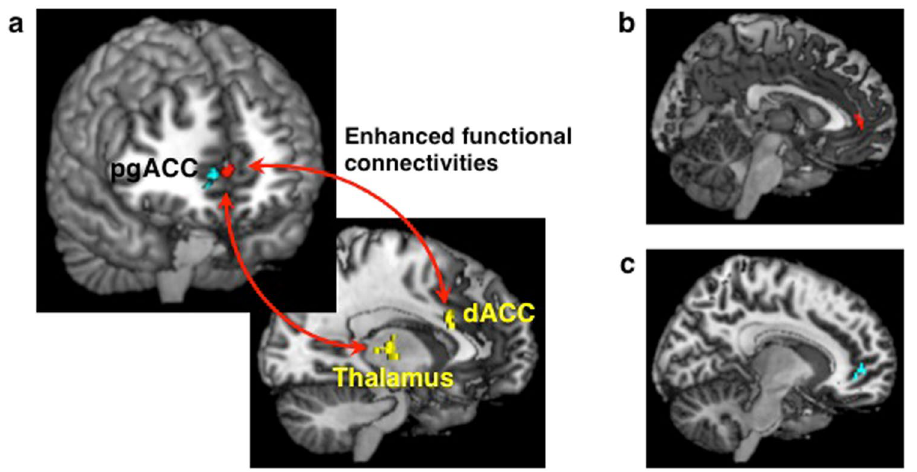
Figure 3. ( a ) Neural basis of negativity bias in facial perception. Activation of the bilateral pgACC (peak Montreal Neurological Institute coordinates: x, y, z = 0, 46, 4; Z = 3.55, red cluster in upper panel) during “sad” versus “happy” choices in response to ambiguous faces was negatively correlated with the point of subjective equality (PSE). The Beck Hopelessness Scale (BHS) score was positively correlated with functional connectivities of the bilateral pgACC with the right dACC and right thalamus (yellow clusters in lower panel). The right pgACC (x, y, z = 8, 46, 2; Z = 4.23, blue cluster in upper panel) exhibited a significant negative correlation with the PSE in the contrast of 100% “sad” versus 100% “happy” faces. Significant clusters in the left putamen and the left orbitofrontal cortex are not displayed. ( b ) Sagittal section showing the bilateral pgACC activity, which was negatively correlated with the PSE in the contrast of “sad” versus “happy” choices in response to ambiguous faces. This cluster was consistent with the red cluster in ( a ). ( c ) Sagittal section showing the right pgACC activity, which was negatively correlated with the PSE in the contrast of 100% “sad” versus 100% “happy” faces. This cluster was consistent with the blue cluster in ( a